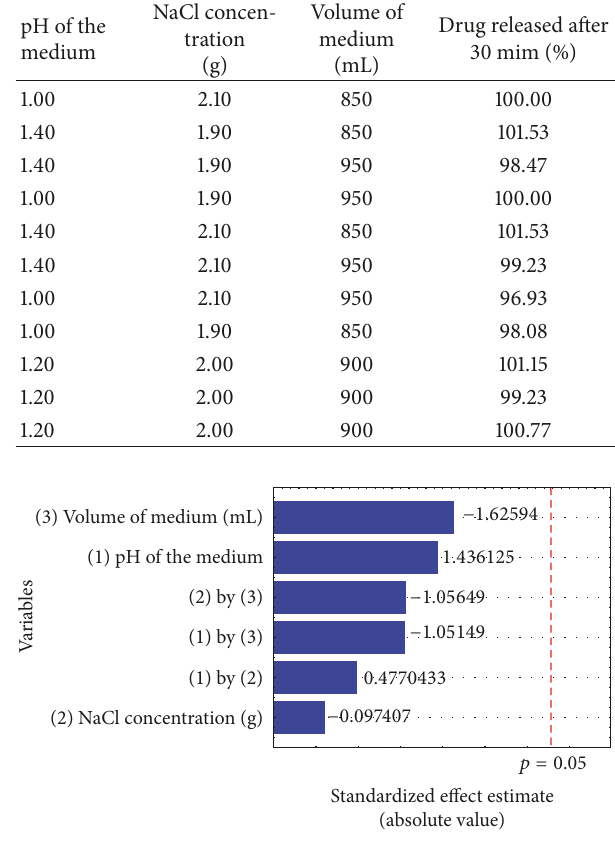
Figure 3: Variables implemented in the study of the robustness versus the absolute value of the